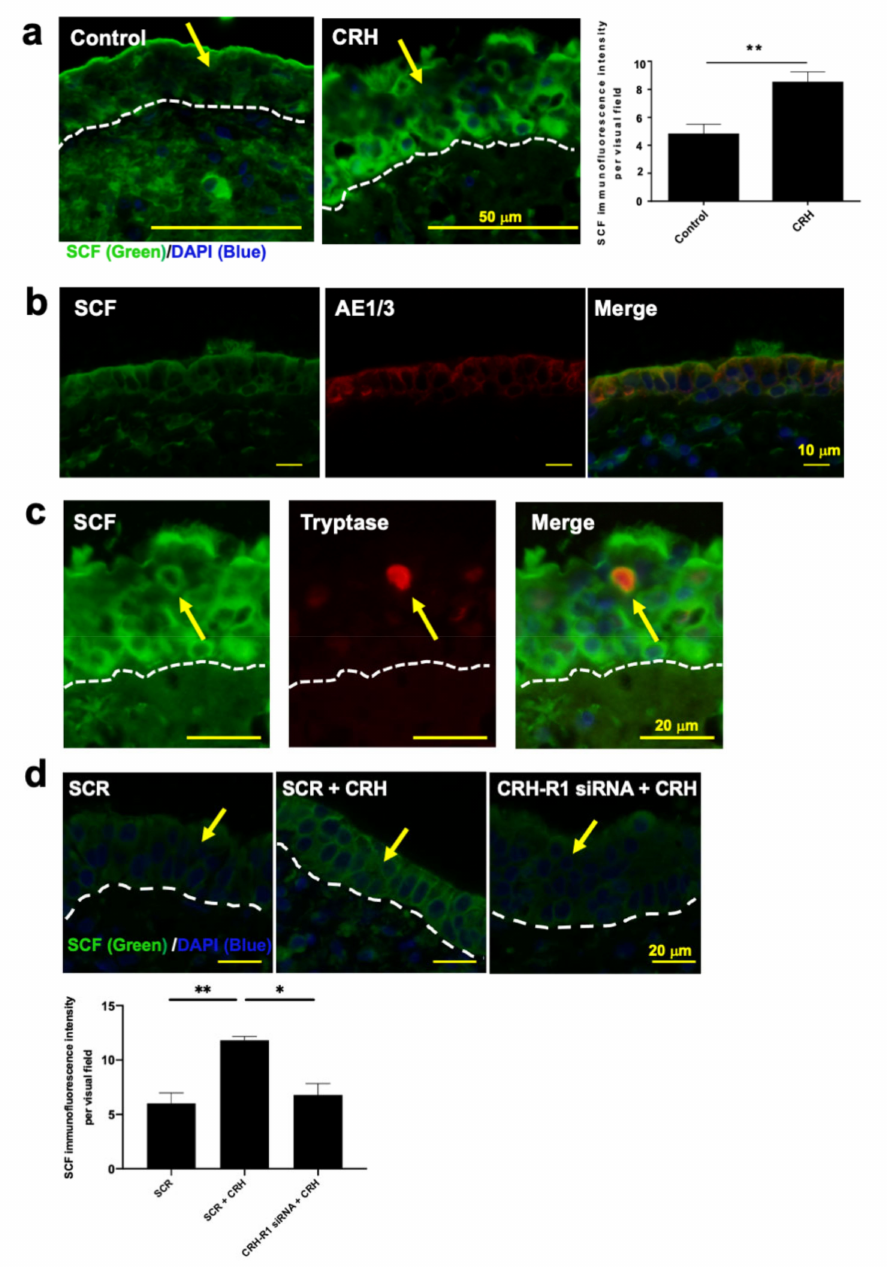
Figure 4. CRH increased stem cell factor (SCF) expression in the mucosal epithelium in NPs. ( a ) SCF immunofluorescence of organ-cultured human NPs treated with vehicle or CRH (10 − 7 M). CRH significantly increased SCF expression within the epithelium of 1 day organ-cultured human NPs. The arrow denotes SCF-positive immunoreactivity within the epithelium. n = 6; scale bar = 50 µ m. ( b ) Double immunofluorescence for AE1/3/SCF and ( c ) tryptase/SCF of CRH-treated NPs. Most of the SCF+ cells were epithelial cells. Some tryptase+ hM-MCs within the epithelium expressed SCF. The arrow denotes SCF+ hM-MCs; n = 4 in ( b ) and 6 in ( c ). Scale bar = 10 µ m in ( b ), 20 µ m in ( c ). ( d ) SCF immunoreactivity in NP epithelium with CRH-R1 siRNA-treated human NPs. The arrow denotes SCF-positive immunoreactivity within the epithelium. n = 4; scale bar = 20 µ m. Error bars indicate SEM. * p < 0.05, ** p < 0.01. MC, mast cell; SCF, stem cell factor; hM-MCs, human nasal mucosa MCs; NPs, nasal polyps; CRH, corticotropin-releasing hormone; CRH-R1, CRH receptor type 1; CRH-R1 siRNA, CRH-R1 siRNA-treated NPs; SCR, scrambled siRNA-treated NPs; DAPI,